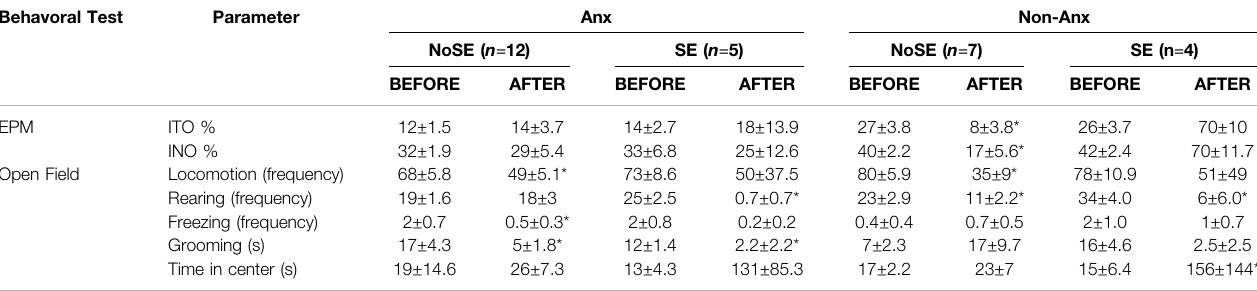
EPM,elevatedplusmaze.ITO,relationbetweenthetimespentintheopenarmsandthetimespentinbotharms;INO,relationbetweenthenumberofentriesintheopenarmsandthetotal number of entries. Locomotion, frequency that animals crossed the different delimited fi elds in the open fi eld arena.Values: mean ± SEM, * p ≤ 0.05 before vs after (Paired t -test).